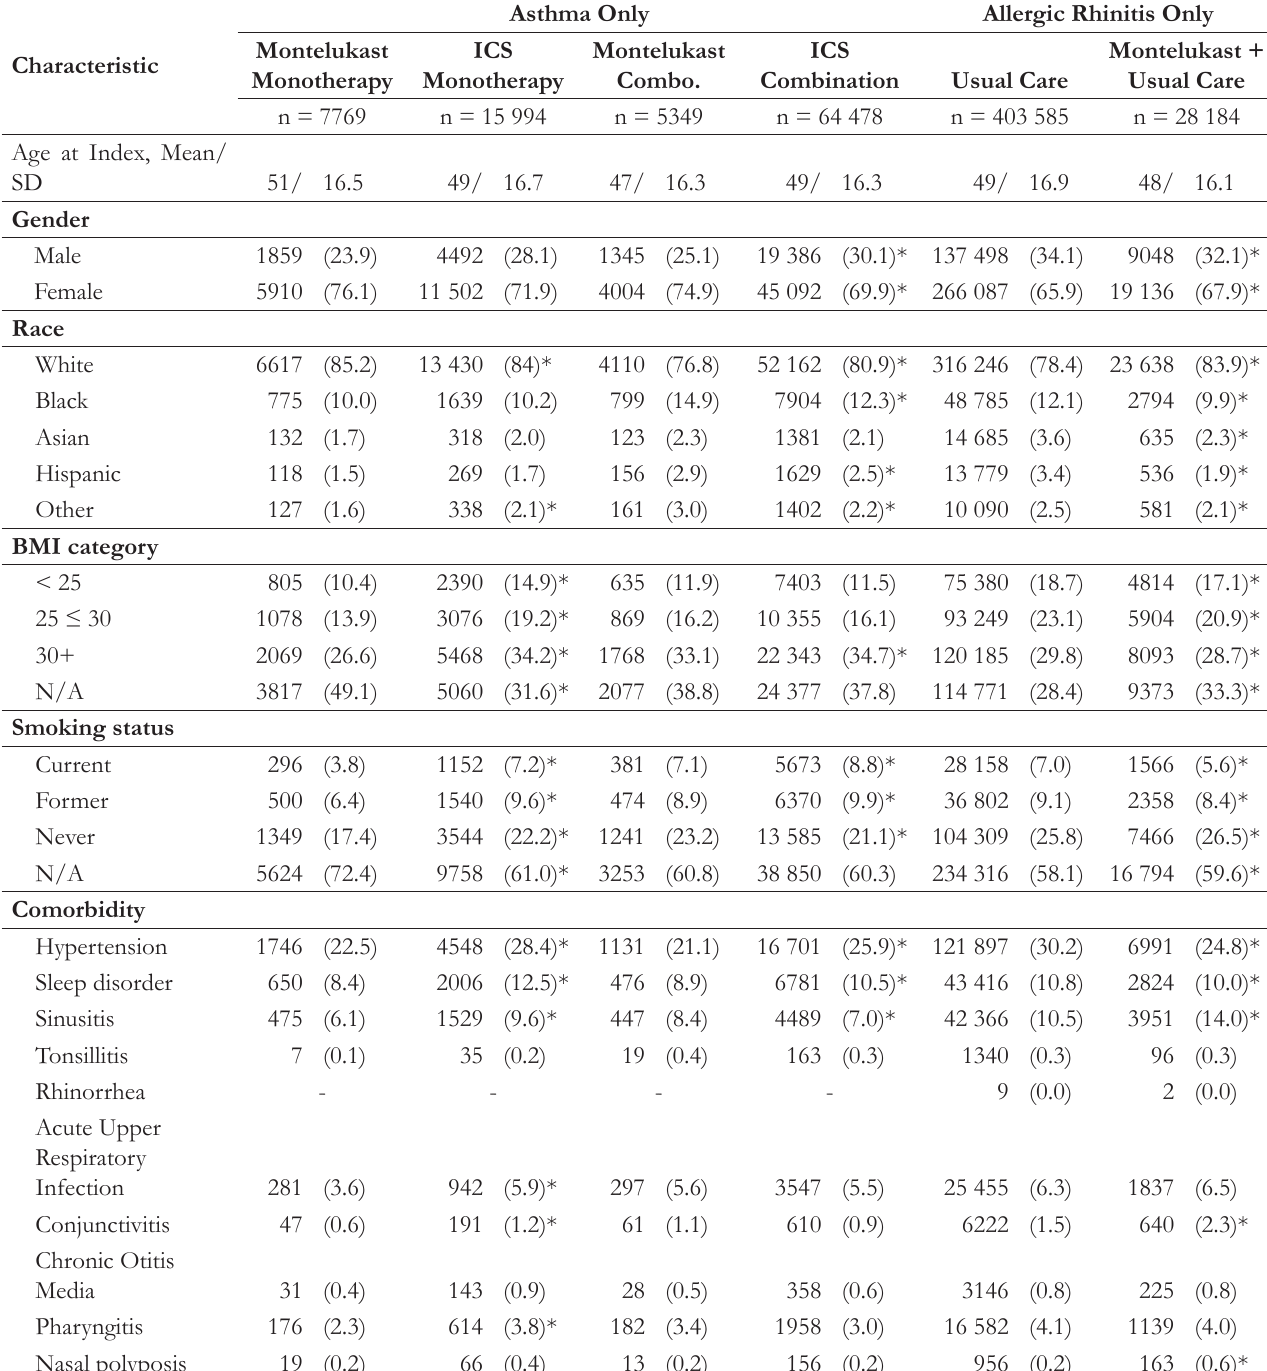
Table 1. Demographic and Clinical Characteristics of Study Patients Characteristic